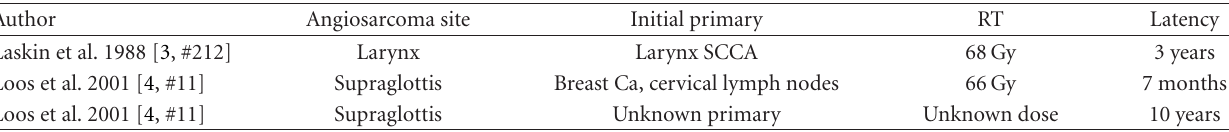
Table 2: Radiation-associated angiosarcoma of the larynx.